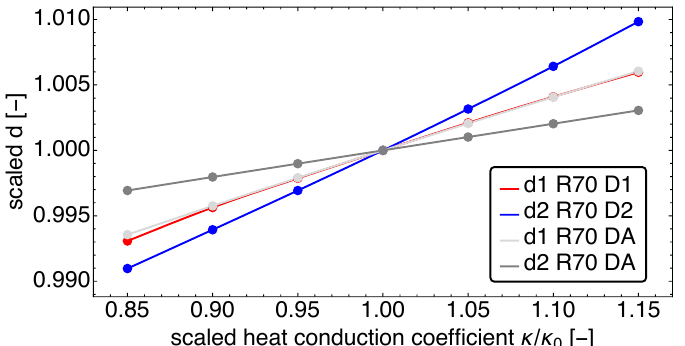
d 1 and 2 are shown as functions of the rescaled heat